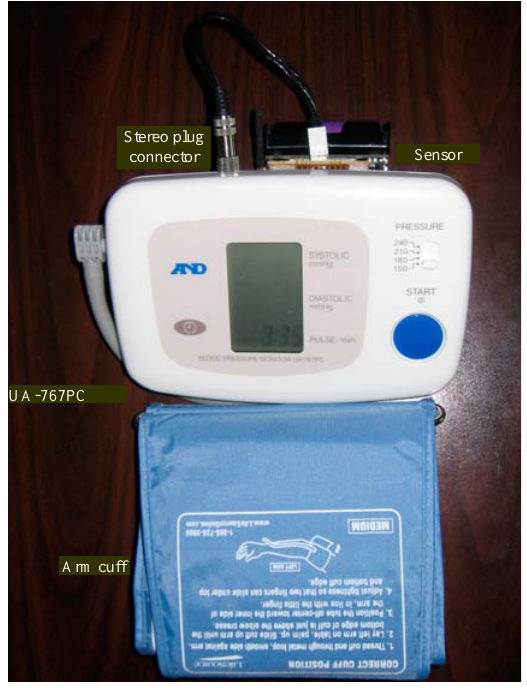
Figure 7. Sensor node interfaced to an A&D UA-767PC